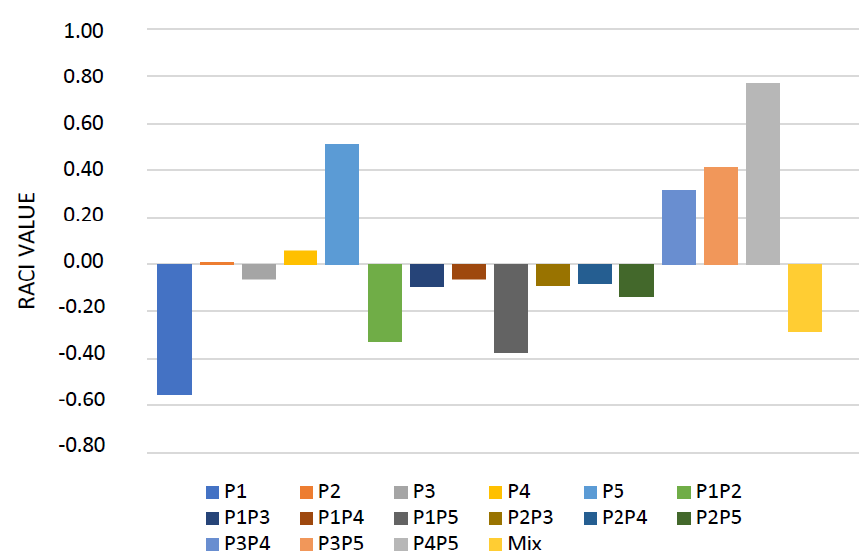
Figure 4. Relative Antioxidant Capacity Index by pomelo EOs and their blends. Mix: sample obtained by combination P1, P2, P3, P4, and P5 EOs (1:1 v / v ).